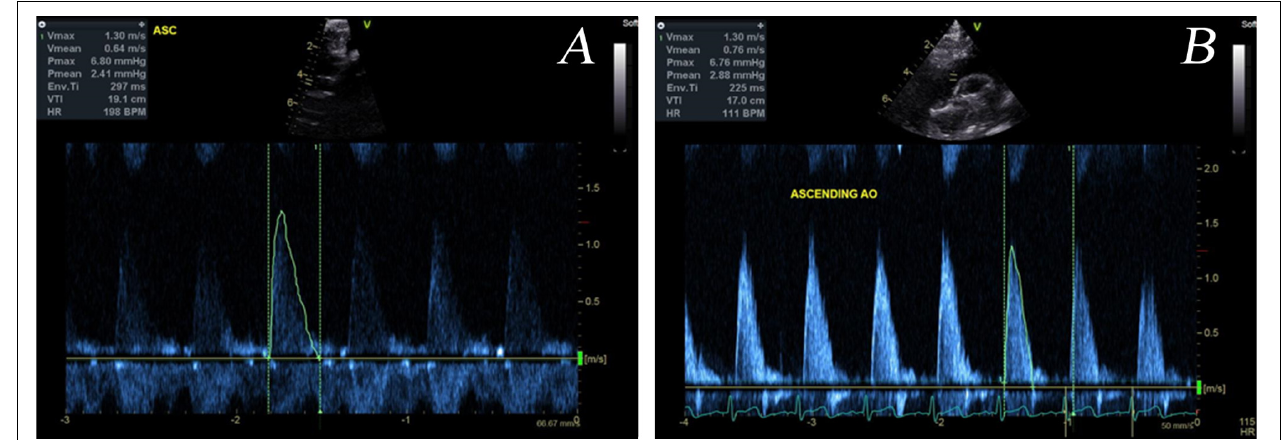
FIGURE 3 | Example Doppler echocardiography dataset taken at the ascending aorta pre- (A) and post-repair (B) . The velocity time plot that was digitized is